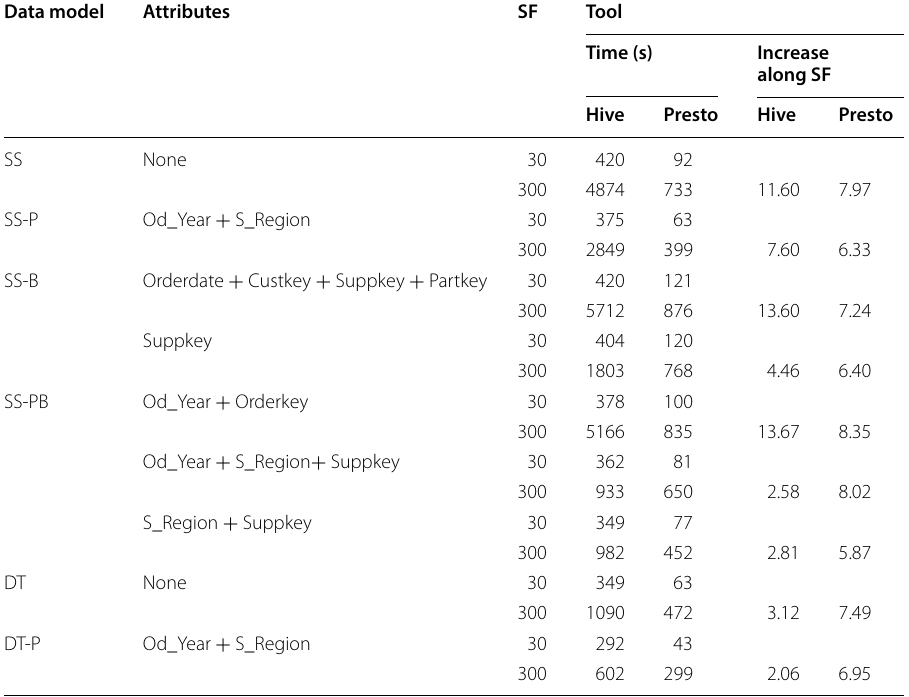
Table 20 Total query execution time for 30 GB and 300 GB Data